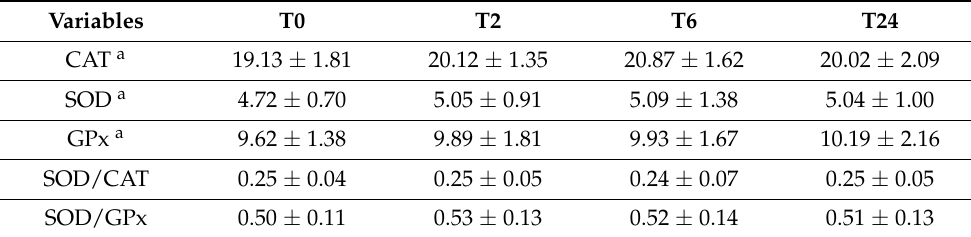
Table 5. Plasma catalase, superoxide dismutase and glutathione peroxidase activities analysis.